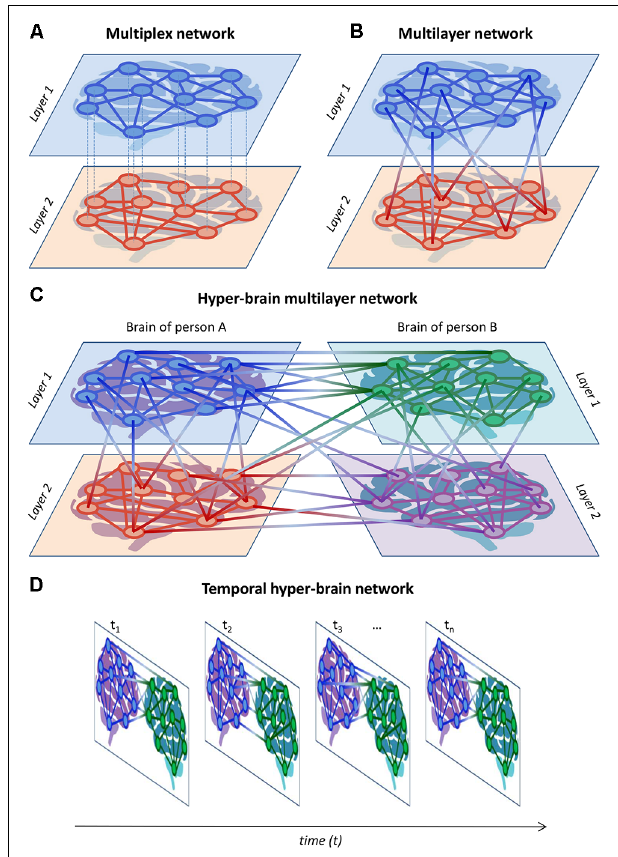
FIGURE 7 | Schematic representation of multiplex, multilayer, and temporal networks. (A) Multiplex network. A two-layer single-brain multiplex network is represented. The layers can represent, for example, different frequencies or other brain attributes (e.g., structural and functional connectivity). (B) Multilayer network. A two-layer single-brain multilayer network is represented, where the nodes are connected within and between the layers. The connections within the layers can be given by WFC and those between the layers by CFC. (C) Hyper-brain multilayer network. A two-layer hyper-brain multilayer network is represented, where the nodes are connected within and between the layers as well as within and between the brains. In the case of an HFN, connections within the layers are given by WFC, connections between the layers are given by CFC, and connections between the brains are given both by WFC and CFC. The two layers of persons A and B can be considered as two different aspects . (D) Temporal hyper-brain network. Network structures can change across time and can be considered multiplex (if the temporal layers do not have any causal relationships or are not connected) or multilayer (if the temporal layers are causally dependent or connected) networks. For simplicity, the connections between the temporal layers were omitted but they would appear if the network was